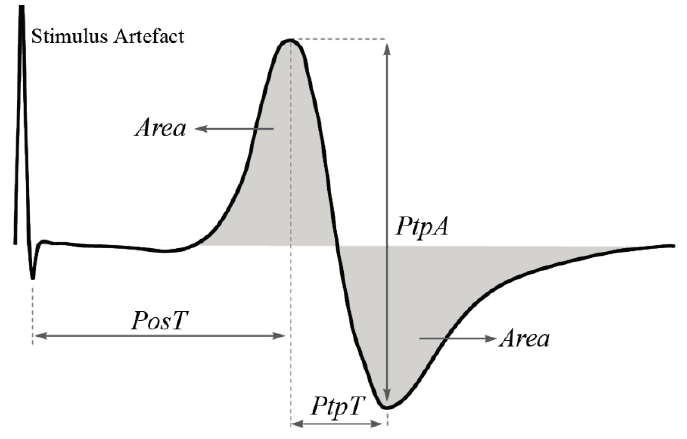
stimulus artefact and the positive peak (PosT), and the m-wave area (Area) as illustrated in Figure 2. Figure 2. The m-wave and its real-time parameters: PosT: positive peak amplitude; NegT: negative peak amplitude; PtpA: peak-to-peak amplitude; PosT: positive peak time; NegT: negative peak time; PtP time: peak-to-peak time; and Area: m-wave area (sum of the two gray shaded